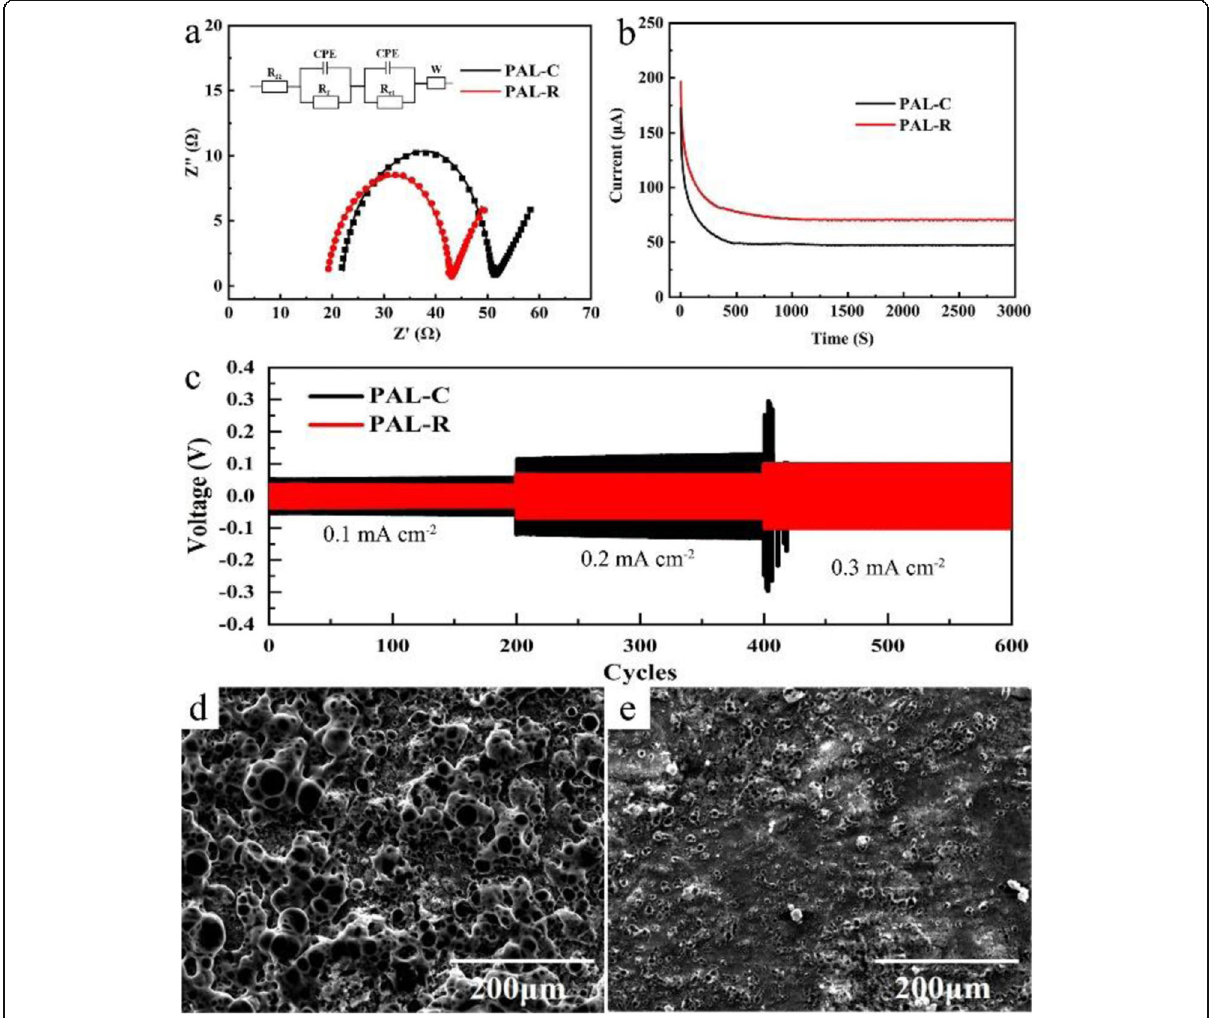
Fig. 2 a EIS plots (inset: the equivalent circuit model). b DC polarization curve and c cycling performance of Li/SPE/Li symmetric cells with different SPEs. d and e The morphology of Li metal after 200 cycles in Li/SPE/Li symmetric cell with PAL-C and PAL-R SPE,